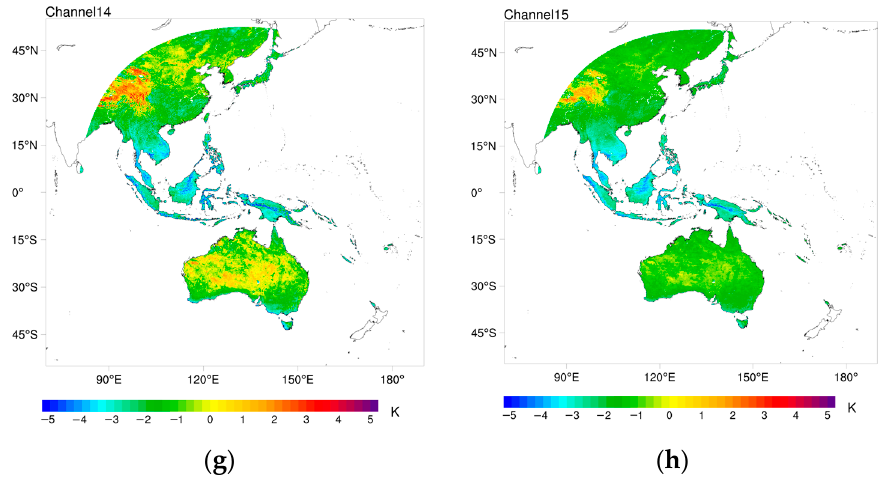
Figure 9. Spatial distributions of biases of the Fengyun-4B/AGRI channels ( a – h ) 8–15 brightness temperature observations and RTTOV simulations over land under clear-sky conditions and with satellite zenith angles less than 60° from June to November 2022.